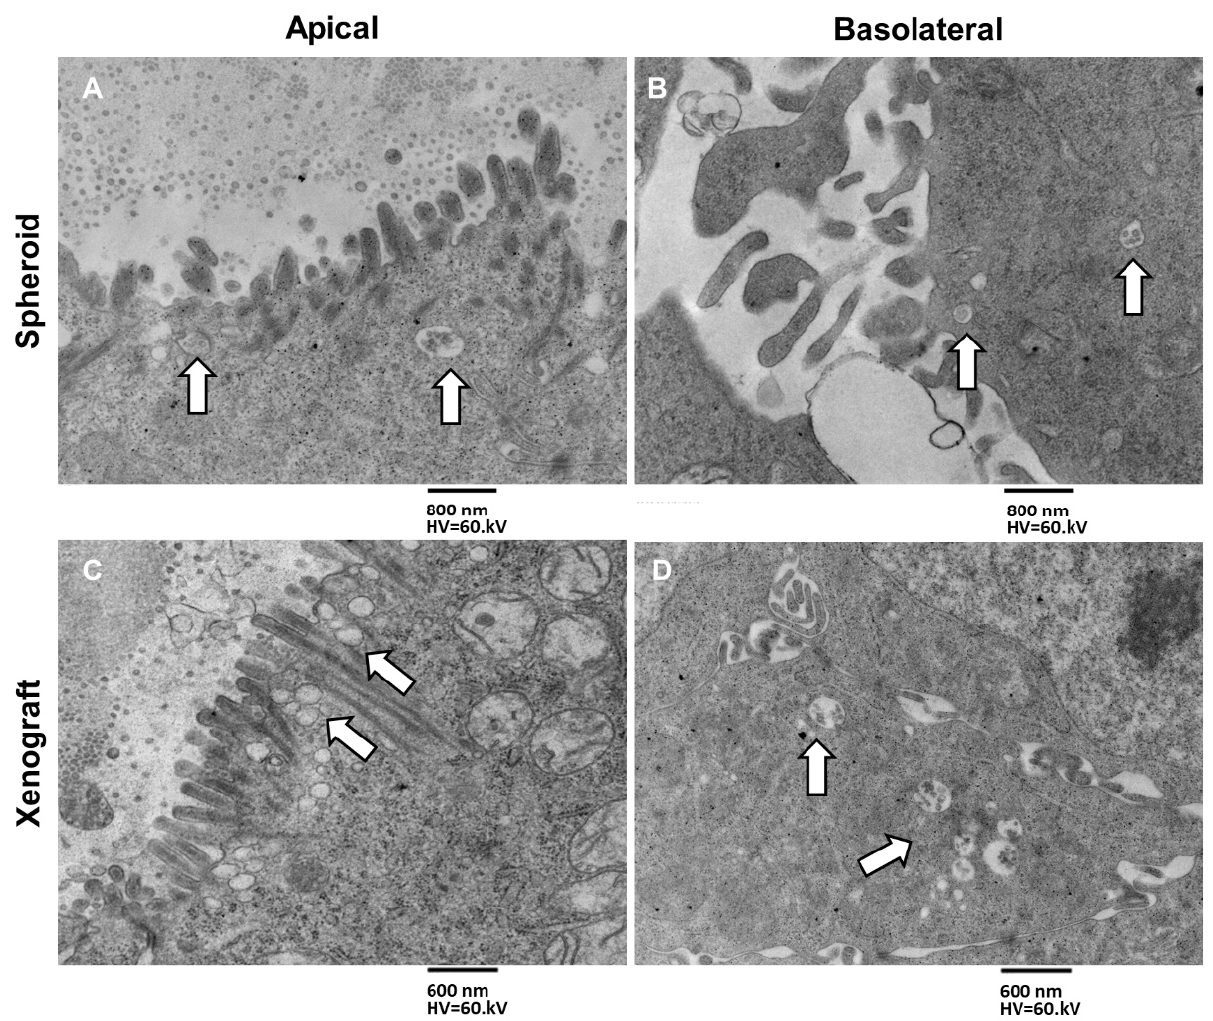
Figure 8. TEM images of exosome secretion pattern in MTSs and xenografts, apical vs. basolateral surface secretion. ( A ) MVBs secretion from spheroid apical surface, arrows indicate MVBs accumulating just beneath the apical membrane, aligning in rows, 6300 × , bar 800 nm. ( B ) MVBs secretion from the spheroid’s basolateral surface, arrows indicate single MVBs approaching the basolateral surface, 6300 × , bar 800 nm. ( C ) MVBs secretion from xenograft apical surface, arrows indicate massive MVBs accumulation just beneath the apical membrane. MVBs arrange in columns perpendicular to the apical membrane, magnification 6300 × , bar 600 nm. ( D ) MVBs secretion from xenograft basolateral surface, groups of MBVs (arrows) accumulating just beneath the basolateral membrane, magnification 6300 × , bar 600 nm. Table 1. Summary statistic of MVBs number in apical and basolateral domains in MTSs and xenograft. MBVs (200 Analyzed Cells for Each